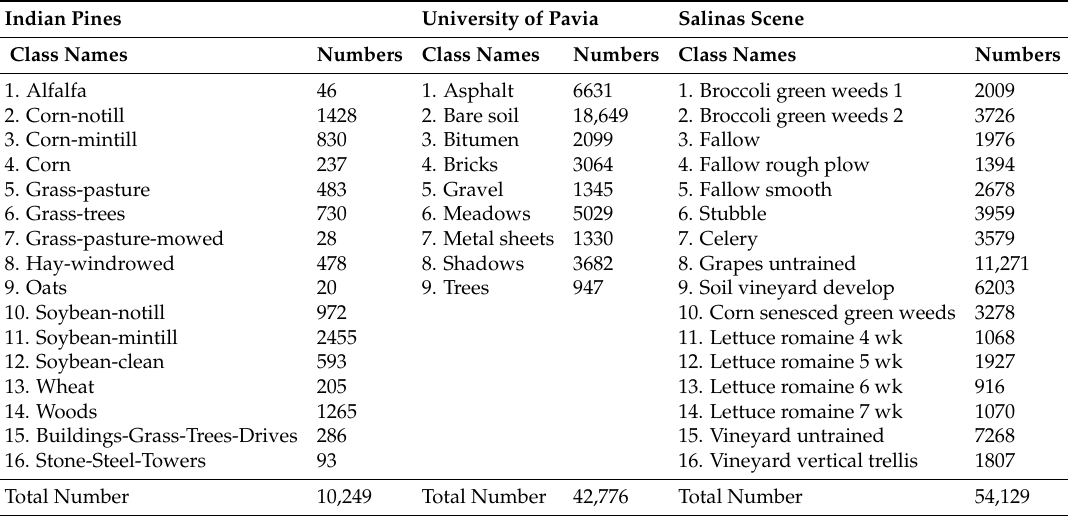
Figure 3. The false color composition of three HSI datasets. ( a ) Indian Pines; ( b ) University of Pavia; and ( c ) Salinas Scene. Table 1. Statistics of the hyperspectral image